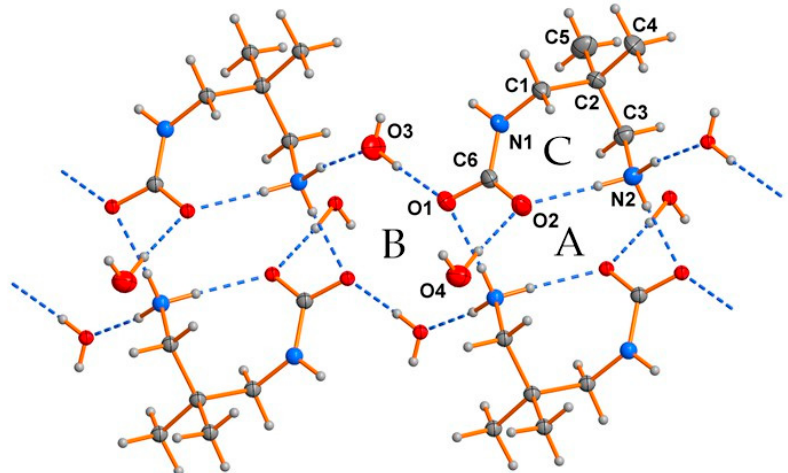
Figure 2. Hydrogen bonds in the title structure. Basic ring motifs along the propagation direction are